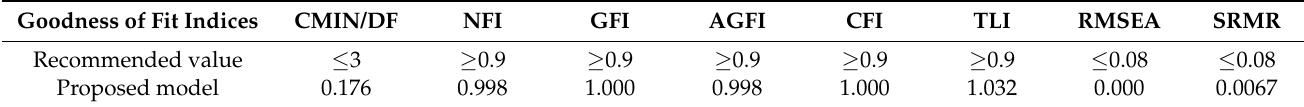
Table 5. Model fit assessment.